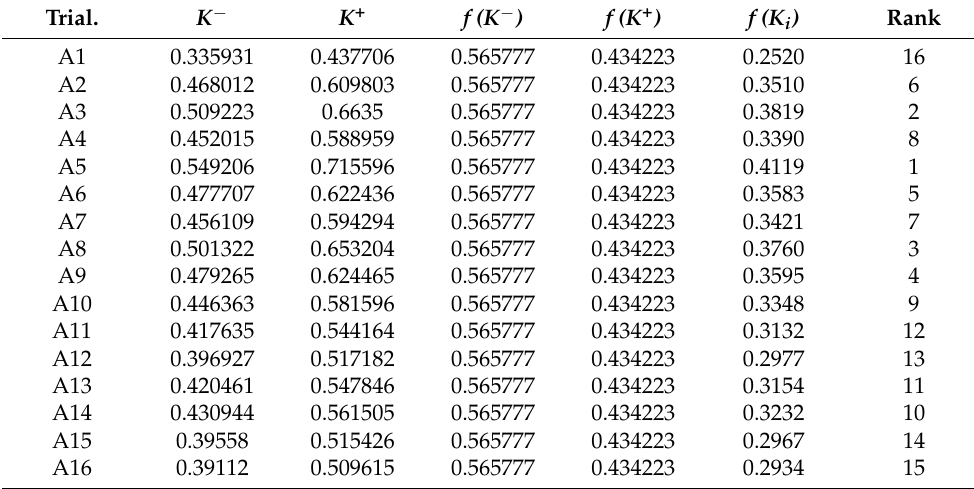
Table 6. Calculated parameters and ranking by the MARCOS method.